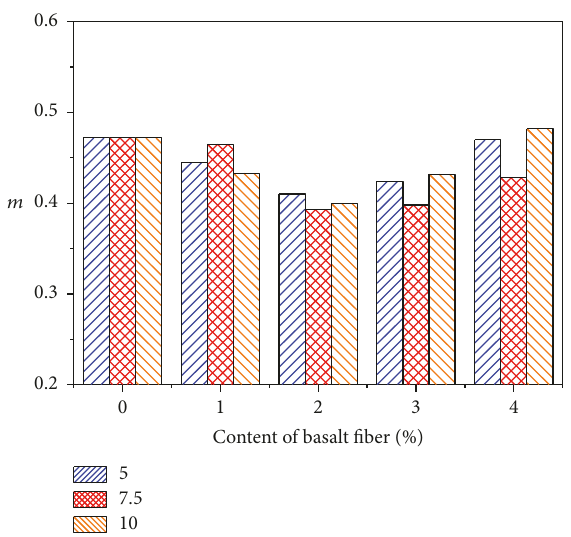
Figure 7: 𝑚 of asphalt mastics versus